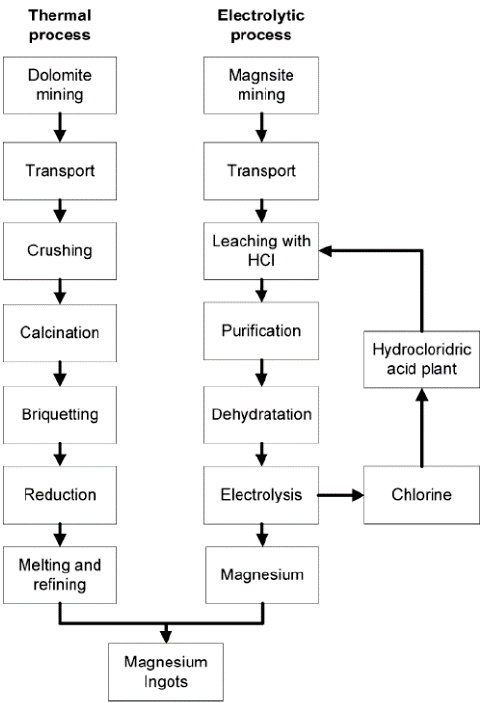
Figure 1. Process flowchart of primary magnesium production via a thermal and electrolytic process. Reproduced with permission from Cherubini, F., et al., LCA of magnesium production; published by Elsevier, 2008 [15].